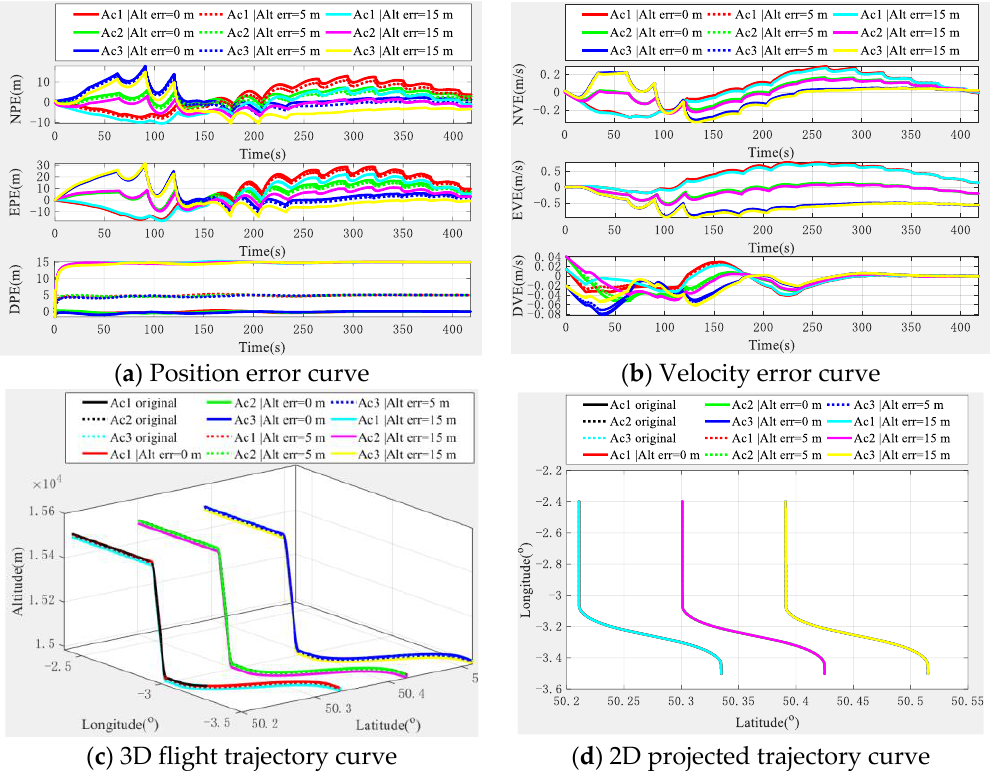
Figure 10. Navigation and positioning error curve when the formation is horizontally collinear.